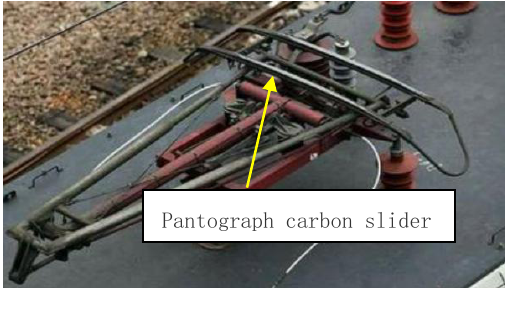
Figure 9. Pantograph.